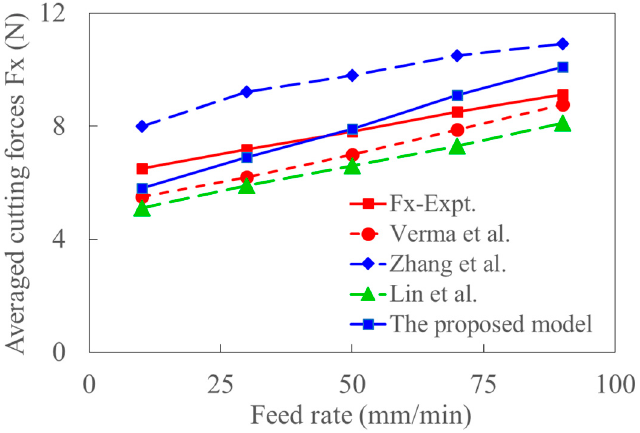
Figure 18. The comparison of predicted and experimental averaged cutting forces with the increase of feed rate (cutting depth: 0.6 mm, Amplitude: 12 um, RPM: 1875).